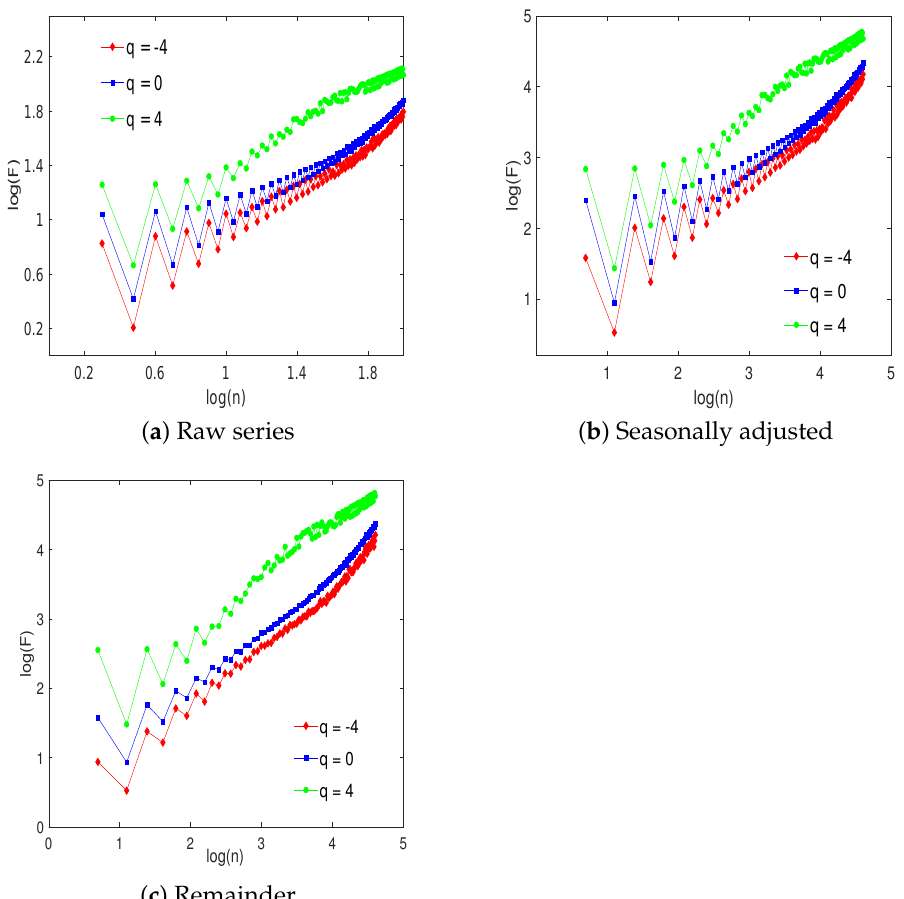
Figure 6. Power law dependence of the fluctuation functions with respect to the scale (log-log